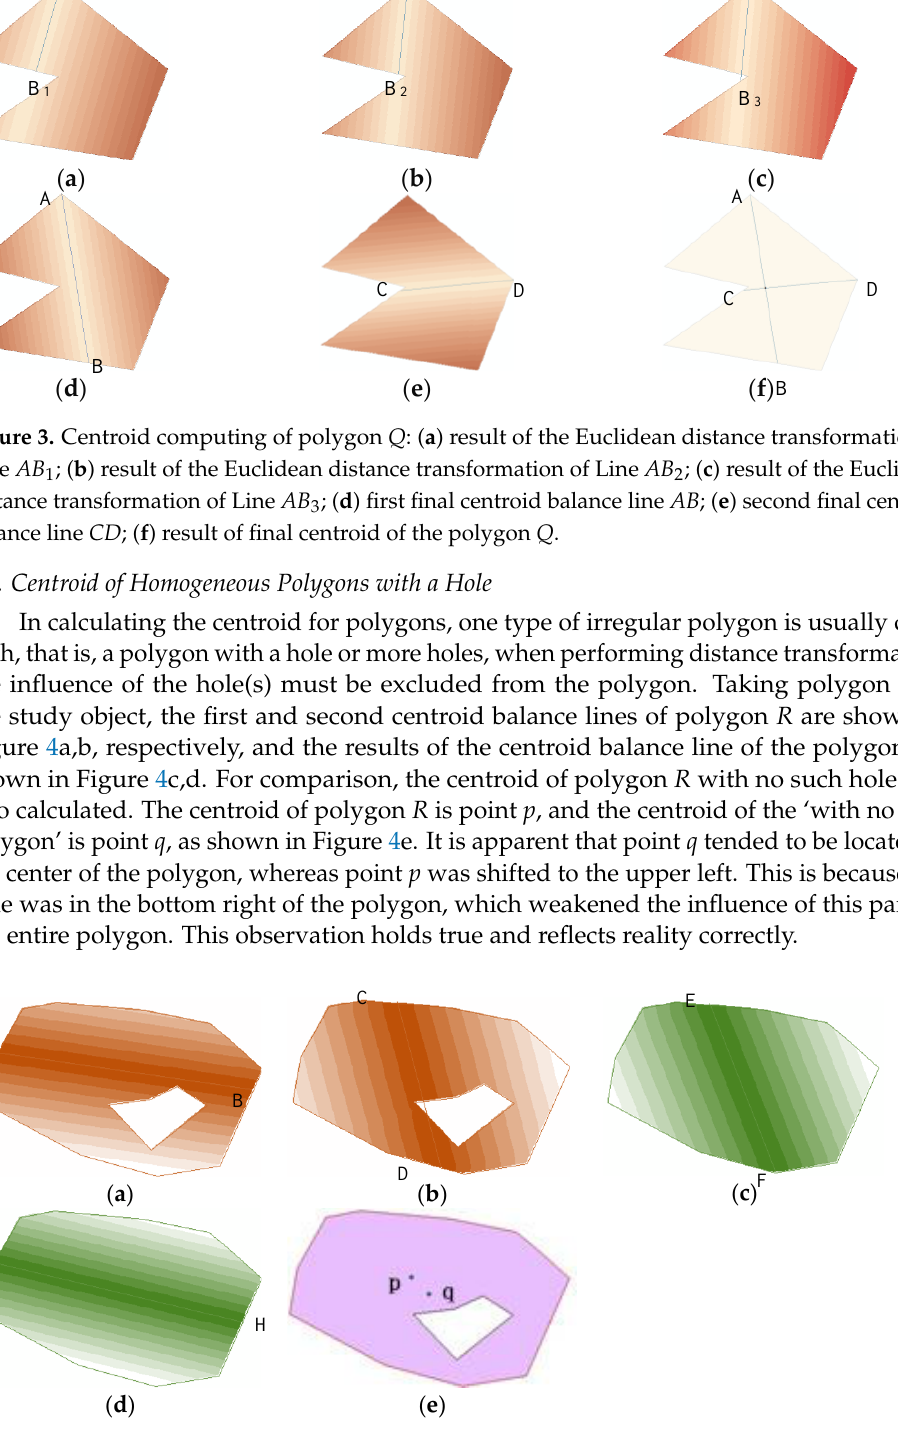
Figure 4 . Centroid computing of polygon R : ( a ) result of the Euclidean distance transformation of Line AB ; ( b ) the result of the Euclidean distance transformation of Line CD ; ( c ) result of the Euclidean distance transformation of Line EF ; ( d ) result of the Euclidean distance transformation of Line GH ; ( e ) final centroids of the polygon R and the polygon without holes but with the same boundary as polygon R .